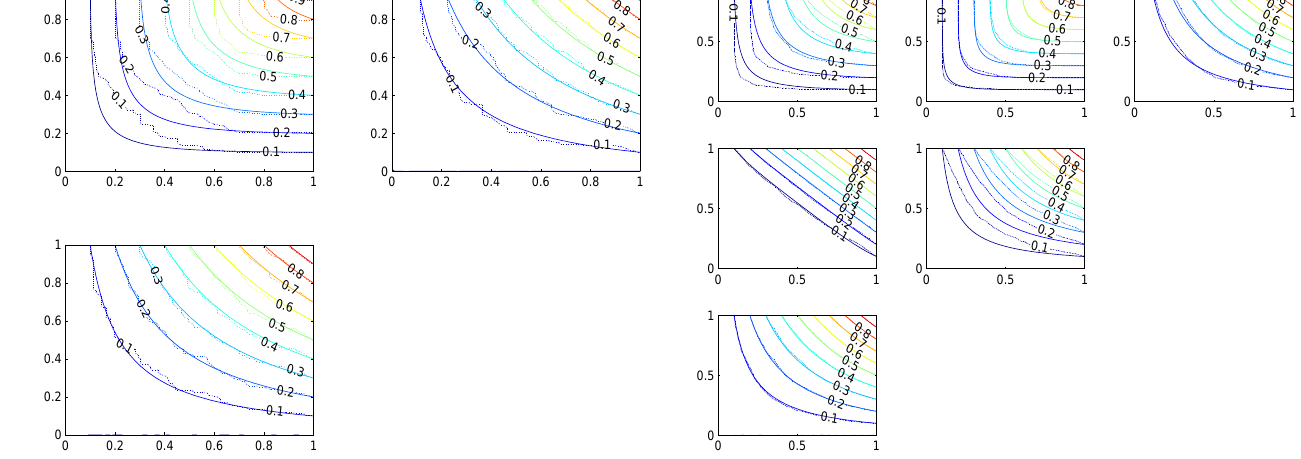
Figure 5. Contour plots of the empirical (dotted lines) and the fitted Frank copulas (solid lines) for the different trees in the 4- dimensional vine copula for season 1. Bivariate copulas between p d and W , W and V , and V and D (top panel), between p d | W and V | W , and W | V and D | V (middle panel) and between p d | WV and D | WV (bottom panel) are shown.